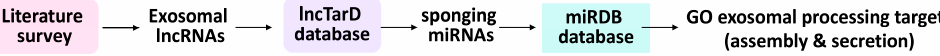
Figure 2. Steps in fi lling the knowledge gap between exosomal lncRNA and sponging miRNAs and between miRNAs and exosomal processing targets, as provided by lncTarD [34] and miRDB [38] databases.